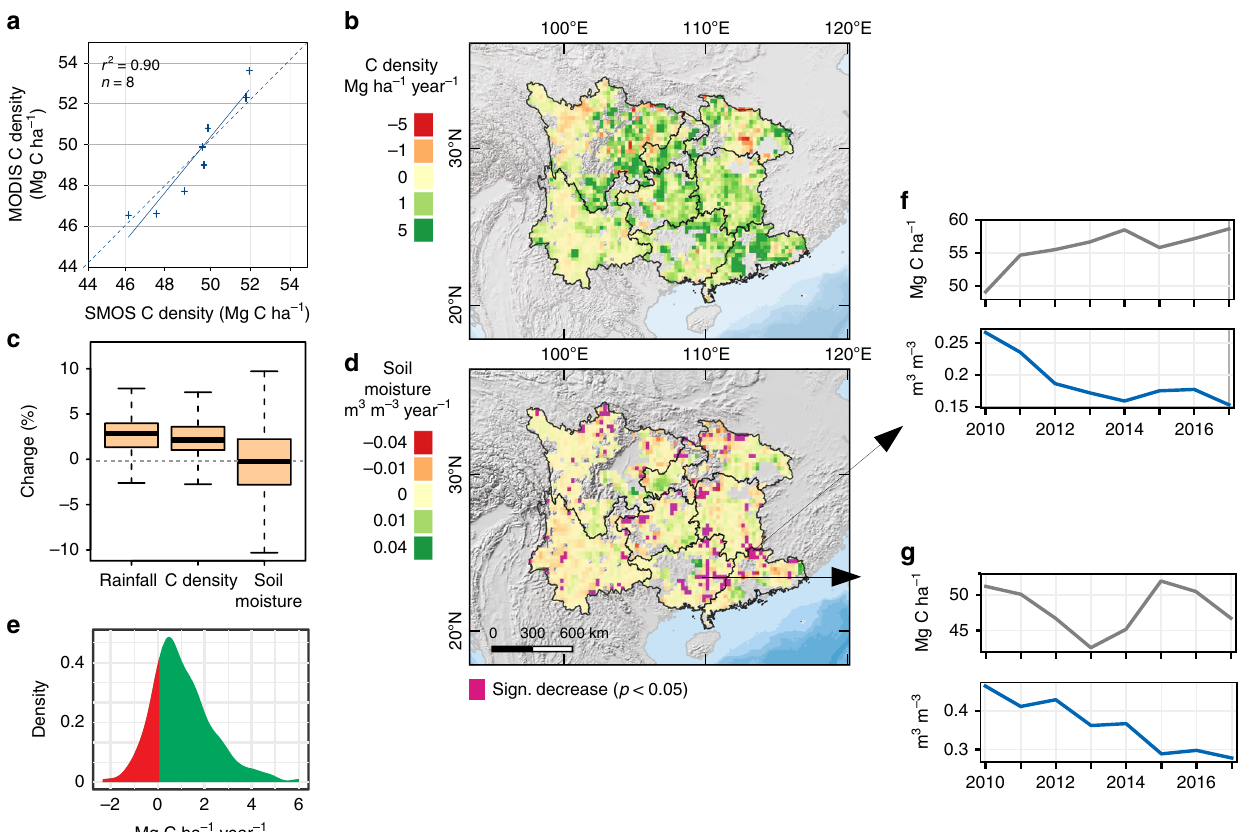
Fig. 2 SMOS-based carbon density and soil moisture changes 2010 – 2017. a Comparison of independent MODIS- and SMOS-based aboveground C density estimates (annual averaged values of the study area). b SMOS aboveground C density trends during 2010 – 2017. c Changes (in %) of CHIRPS rainfall, SMOS C density and SMOS soil moisture during 2010 – 2017. Boxplots show whiskers, quartiles and median across 25 × 25 km 2 pixels. d Spatial distribution of SMOS soil moisture trends during 2010 – 2017 ( n = 2279 pixels). Transparent areas have been disregarded for insuf fi cient data quality. Signi fi cant negative trends ( p < 0.05) are shown in purple. e Density plot showing the distribution of SMOS aboveground C density trends in the purple areas of d with a signi fi cant ( p < 0.05) decrease in soil moisture ( n = 172). f Example of an area with a signi fi cant ( p < 0.05) decrease in soil moisture and a strong increase in C density. g Example from Guangxi province showing an area with large-scale tree plantation and massive harvest in 2013 and a signi fi cant ( p < 0.05) decrease in soil